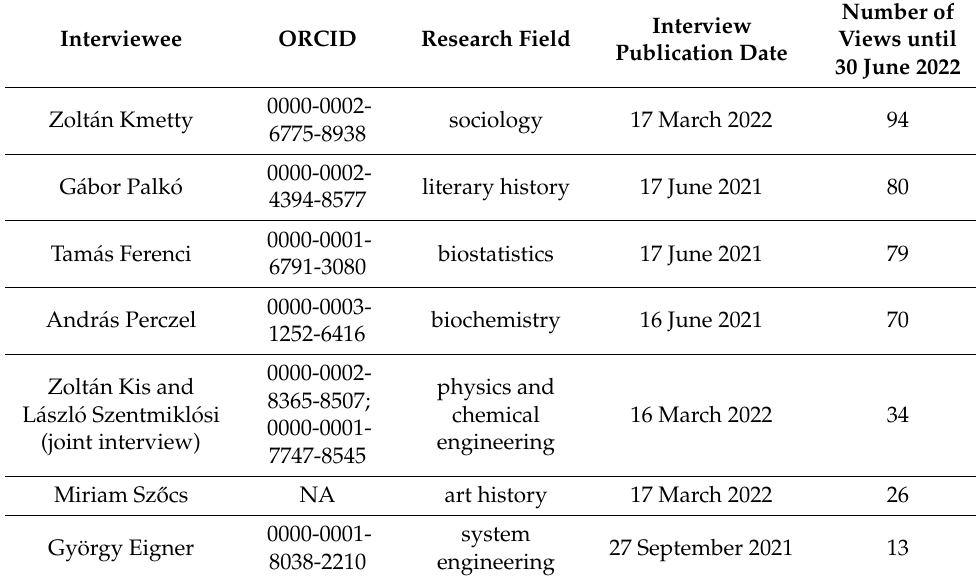
Table 1. Video interviews published as part of the Hungarian NI4OS-Europe activity until 30 June